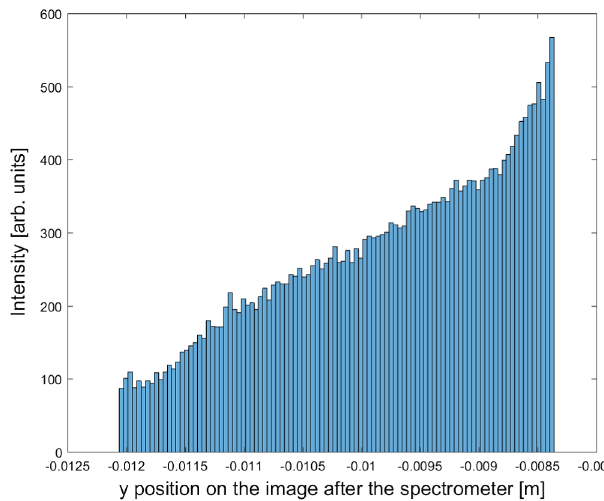
FIG. 8. Intensity distribution f ð y Þ of the pencil beam extracted from the screen-6 image.